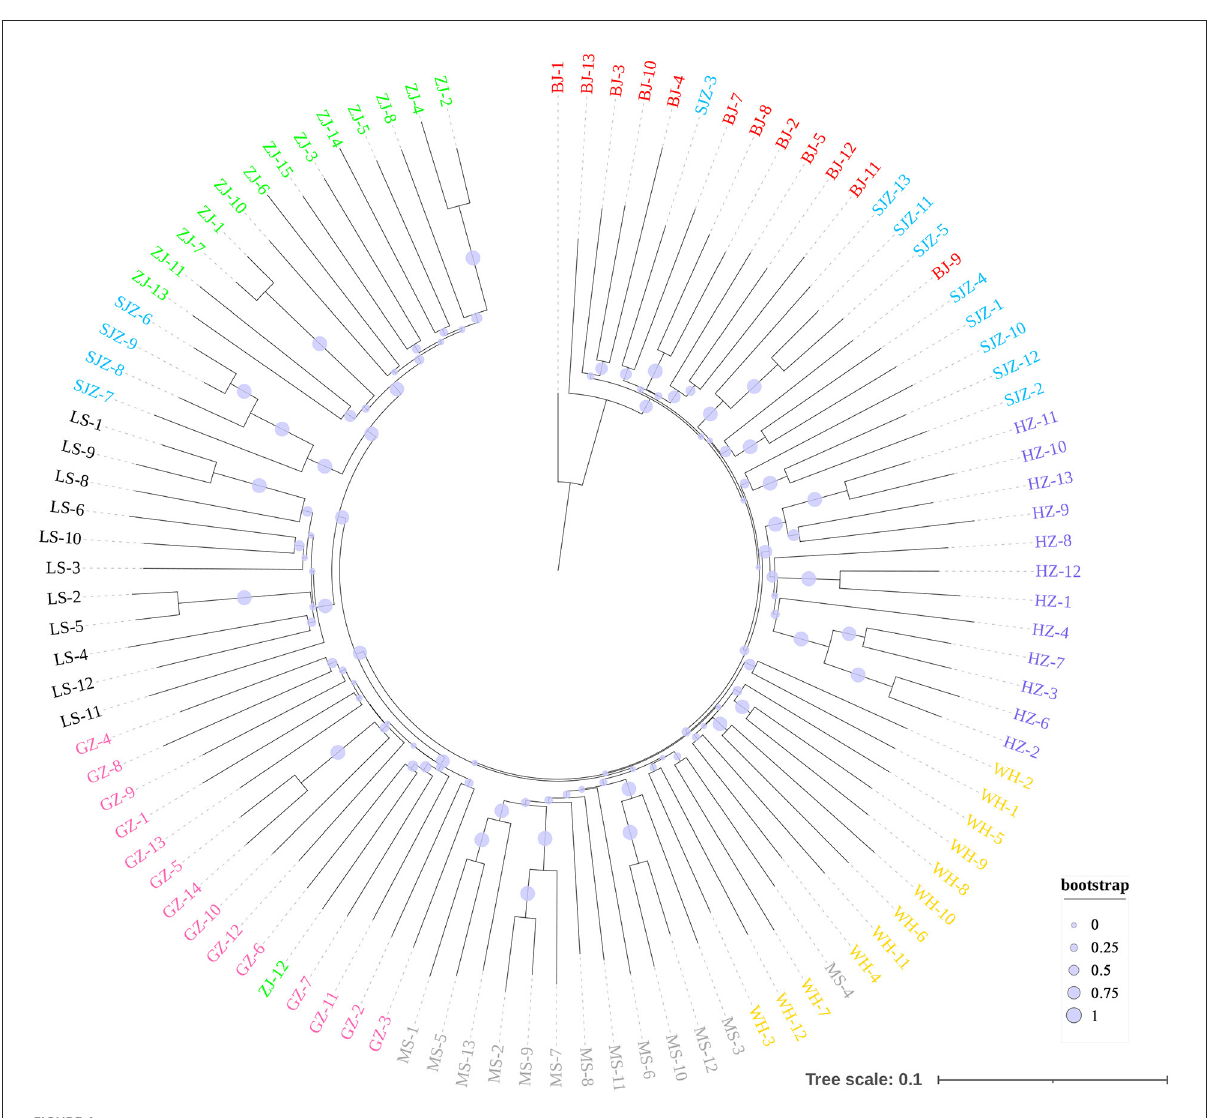
FIGURE4 Neighbor-Joining phylogenetic tree constructed using 9,103 genome-wide